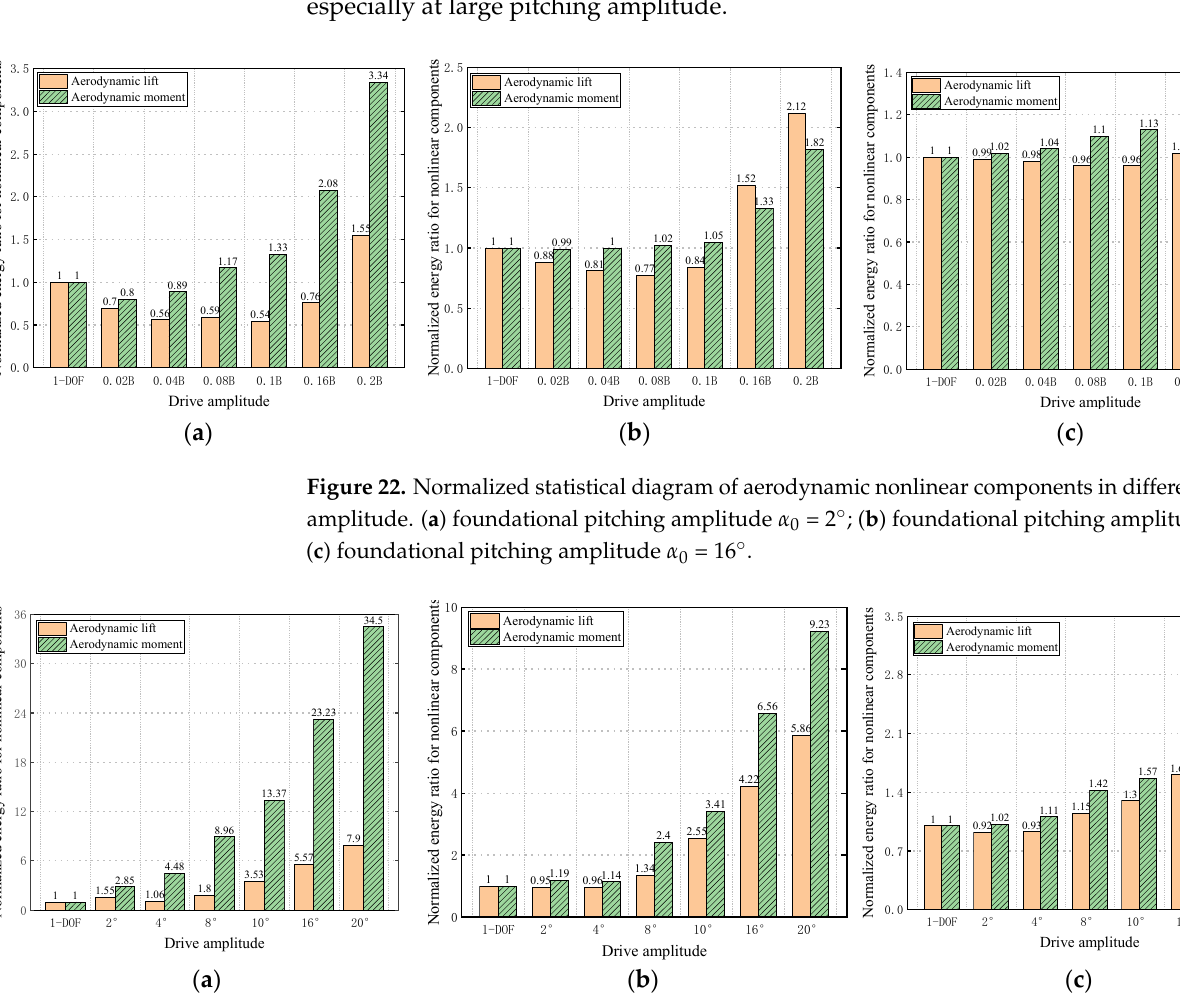
Figure 23. Normalized statistical diagram of aerodynamic nonlinear components in different pitching amplitude. ( a ) foundational heaving amplitude h 0 = 0.02 B ; ( b ) foundational heaving amplitude h 0 = 0.1 B ; ( c ) foundational heaving amplitude h 0 = 0.2 B .